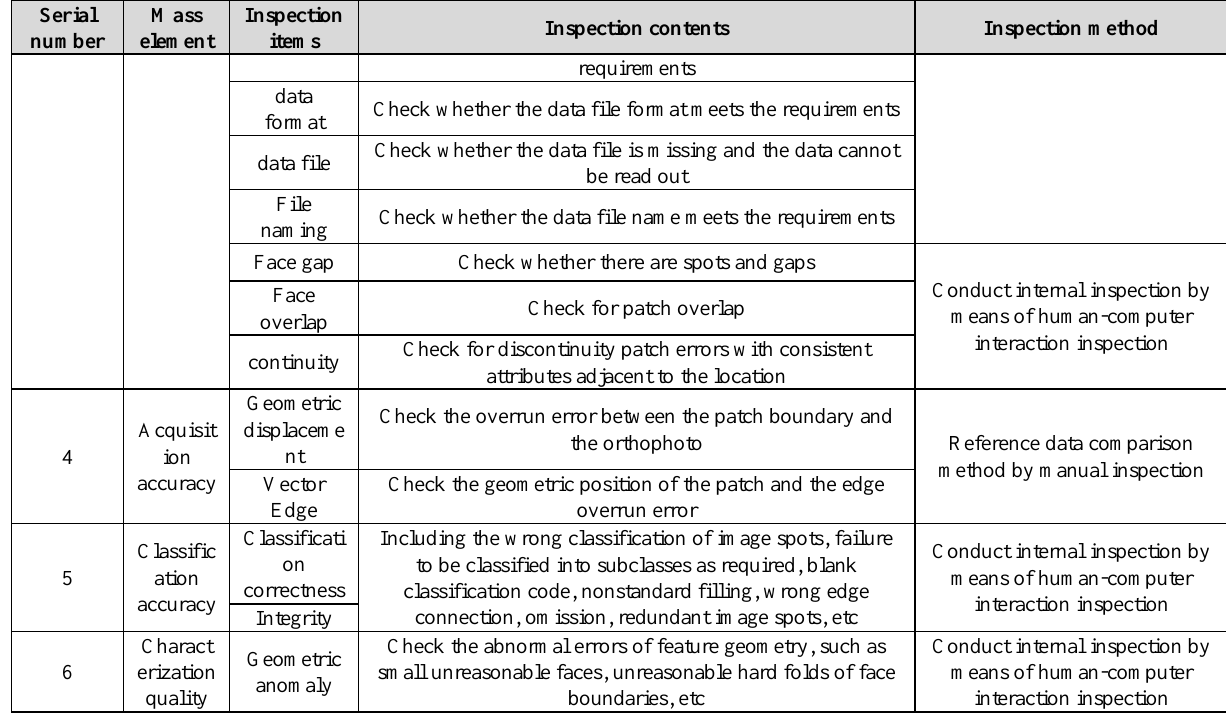
Table 1. Inspection contents and requirements of surface coverage data